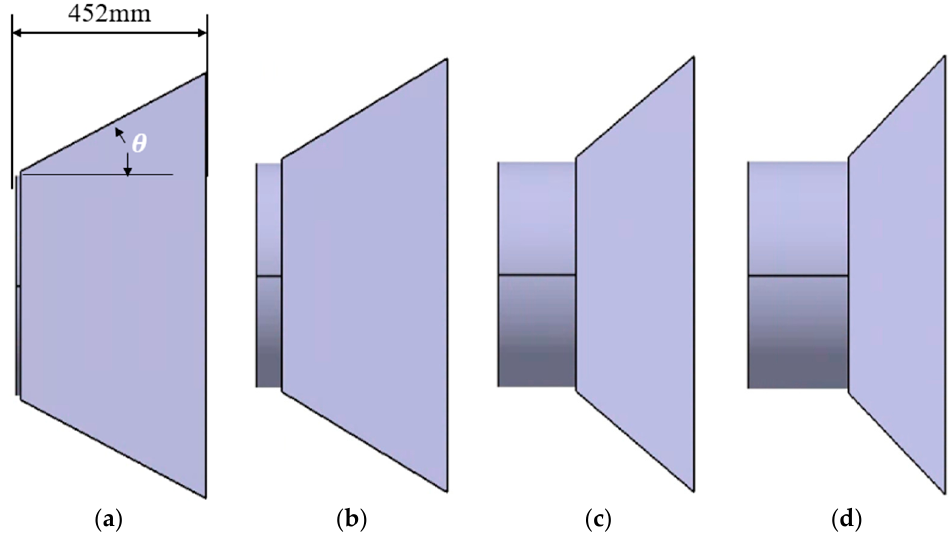
Figure 9. SCR diffuser angle type: ( a ) 25°, ( b ) 30°, ( c ) 35°, ( d ) 40°.